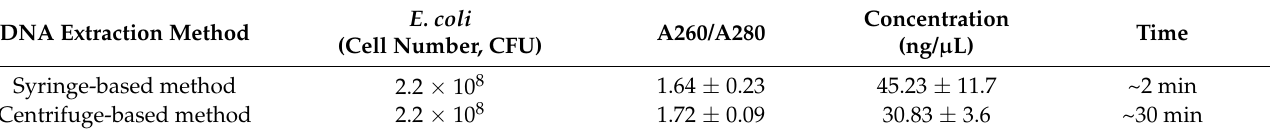
Table 1. DNA extracted from Escherichia coli using syringe-based and centrifugation-based extraction methods. DNA Extraction Method